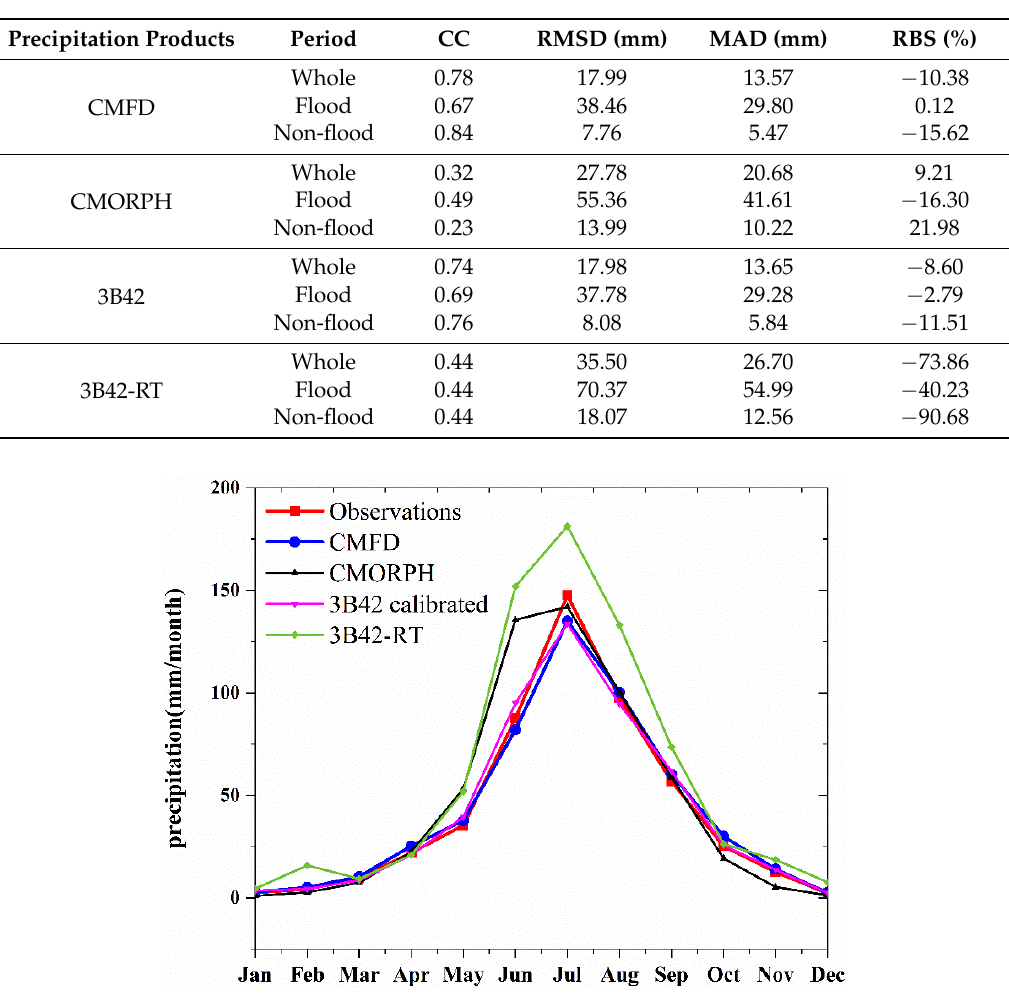
Figure 5. Average monthly precipitation from ground observations and four satellite-derived precipitation products.